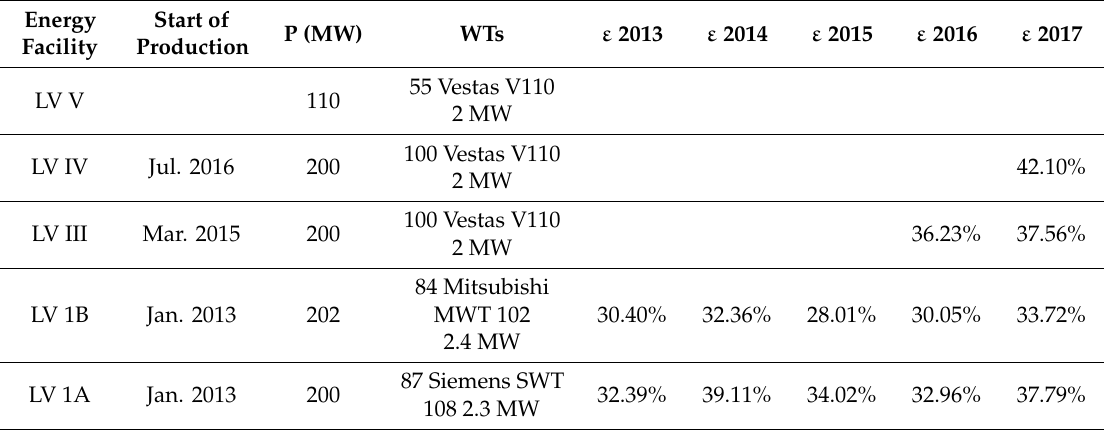
Table 2. Los Vientos (LV) wind energy complex